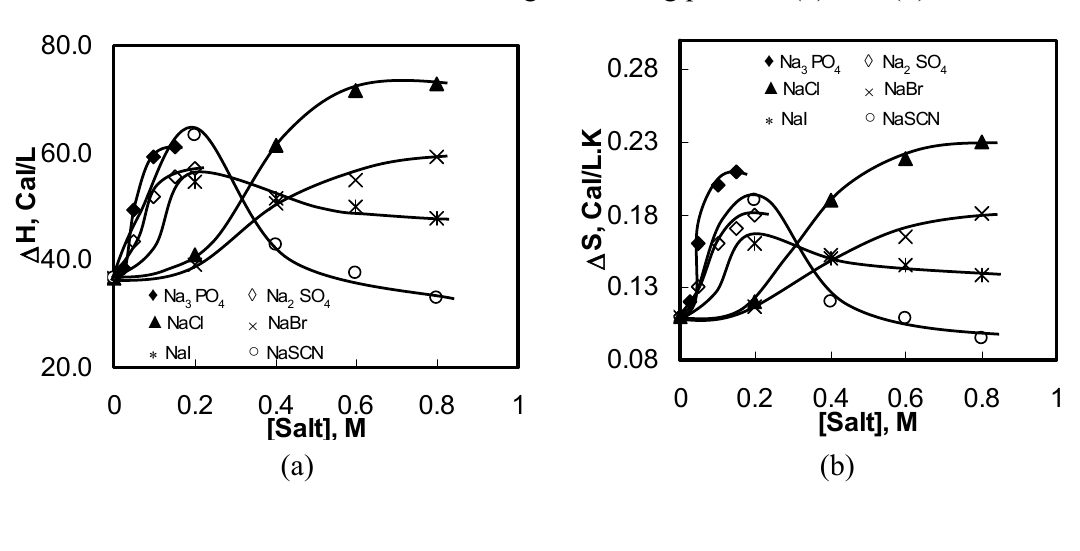
Figure 5. Thermodynamic properties of 1 wt% HPMC aqueous solutions of as a function of the concentration of the added salts during the heating process: ( a ) Δ H; ( b ) Δ